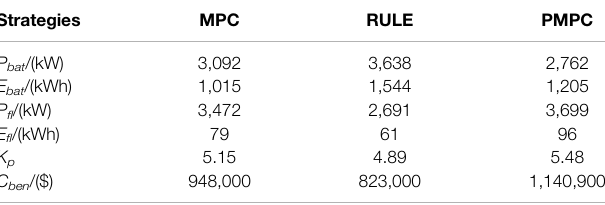
TABLE 4 | Capacity con fi guration results under different strategies. Strategies MPC RULE PMPC